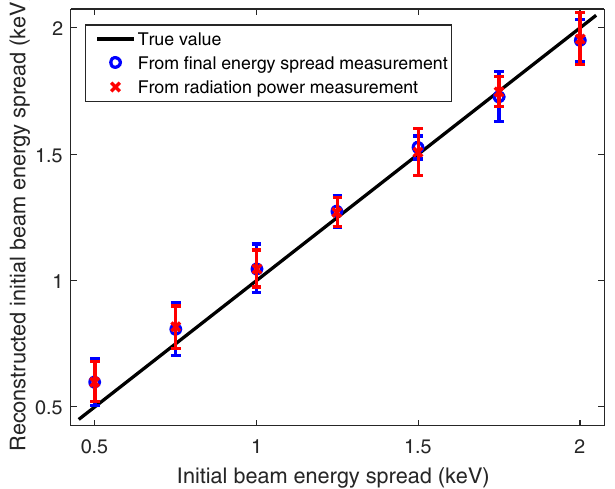
FIG. 5. Simulated reconstructed beam energy spread for differ- ent initial beam energy